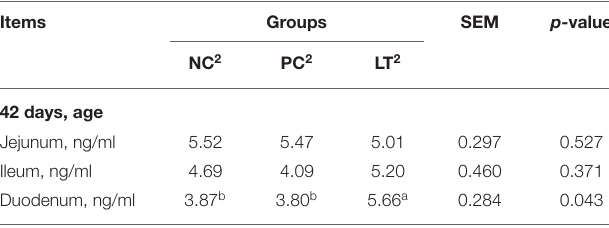
TABLE 5 | Effects of dietary L-theanine on ZO-1 protein of broilers under the oxidative stress 1 .